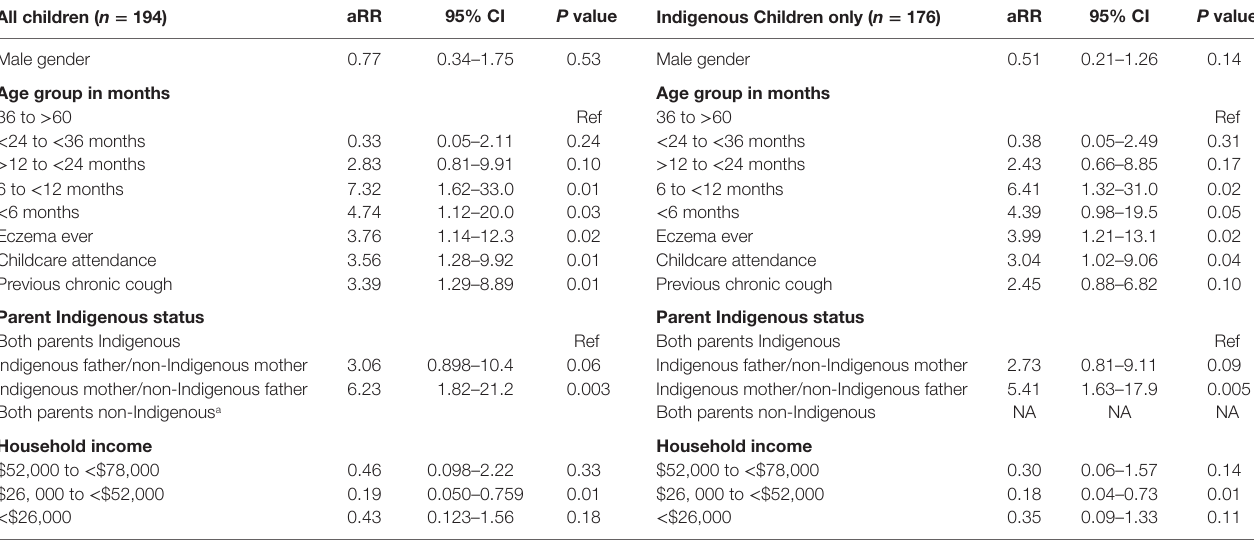
TaBle 4 | Predictors of chronic cough following ARIwC in children aged less than 5 years from an urban disadvantaged community. all children ( n =